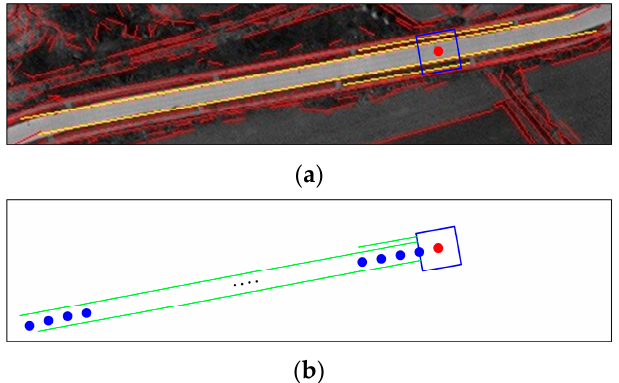
Figure 10. Determination of tracking points with clear geometric characteristics: ( a ) The establishment of search area; ( b ) the obtention of tracking points.